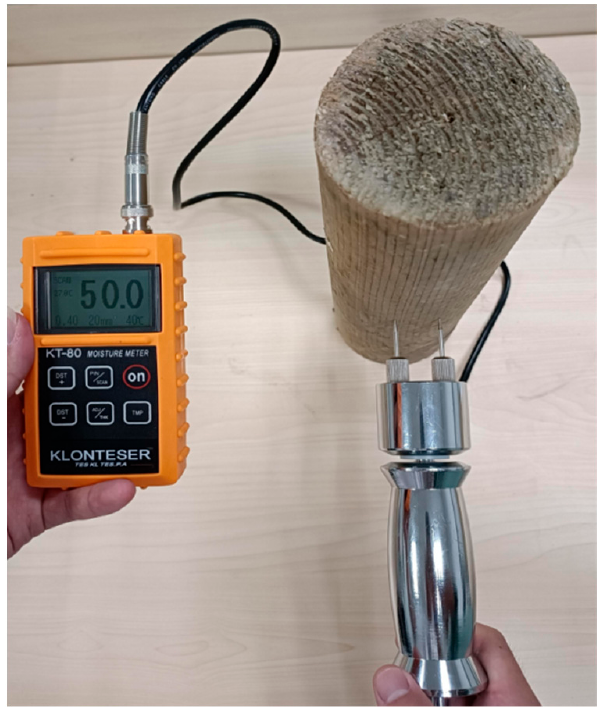
Figure 15. Calibration chart of moisture content of metasequoia wood samples.